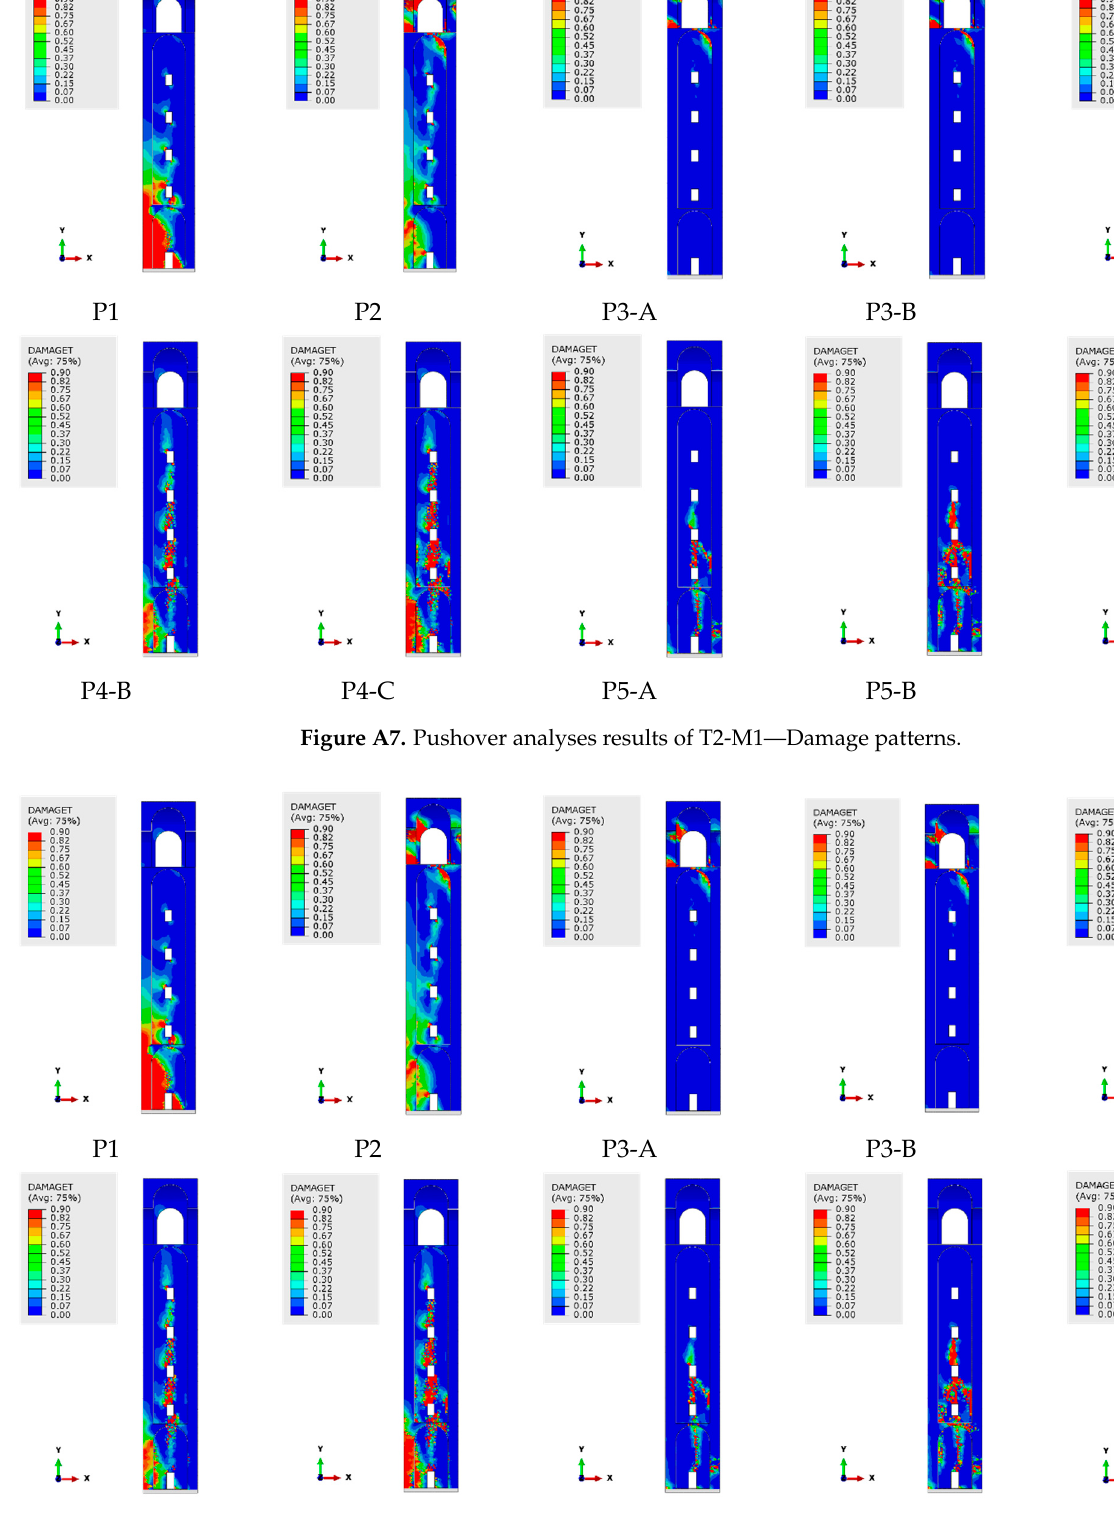
Figure B5. Pushover analyses results of T2-M2—Damage patterns.